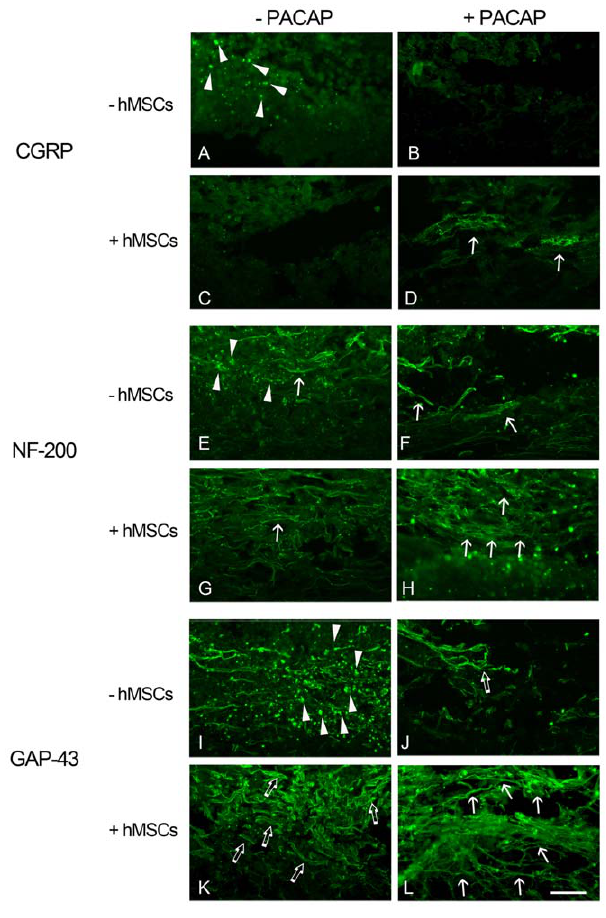
Figure 4. Immunofluorescence staining for identifying the remaining neuronal fibers in the lesion center of the injured spinal cord. After BBB open field scores were performed at day 31, spinal cord tissues were collected. Longitudinal tissue sections were subjected to immunofluorescence for CGRP (A–D), NF-200 (E–H), or GAP-43 (I–L). CGRP positive neuronal fibers were observed in the dorsal section of the spinal cord (D, arrows). Elongated neuronal bundles labeled with CGRP, NF-200, or GAP-43 (arrows in D, H, and L) were observed in the injured spinal cord tissue receiving delayed combina- torial treatment of PACAP and hMSCs. Few NF positive or GAP-43 positive neuronal fibers were seen in the injured spinal cord tissues treated with PACAP (arrows in F and open arrows in G). Fine NF positive fibers (arrow in G) or fragmented GAP-43 positive fibers (open arrows in K) can be detected in the lesion center of the spinal cord with delayed treatment by hMSCs. Arrowheads indicate the cell debris with immunostaining for CGRP (A), NF-200 (E), or GAP-43 (I). Scale bar, 100 m m.